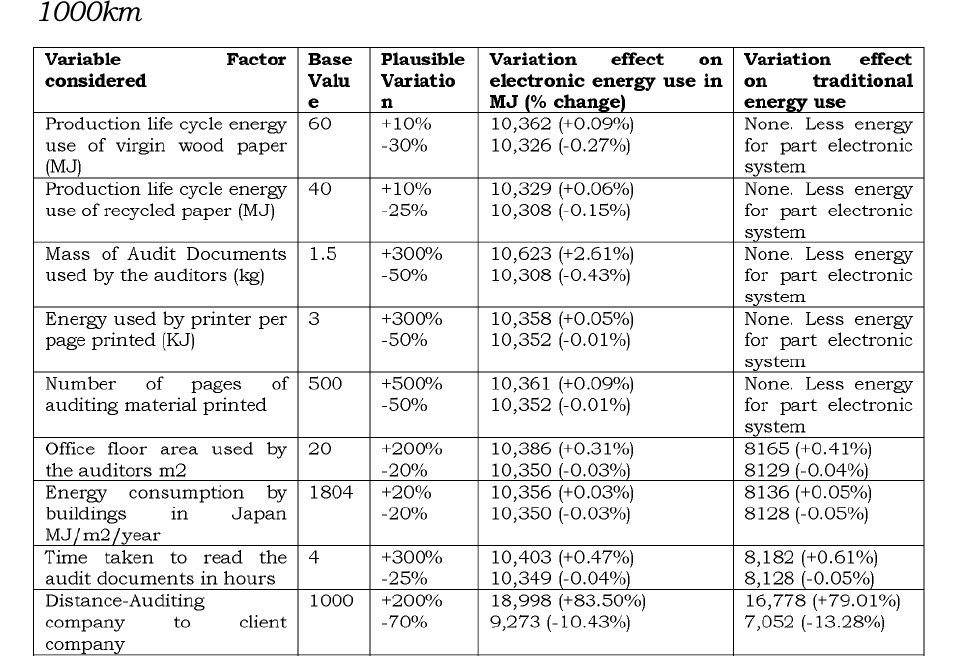
Energy use in the partly electronic model for a distance